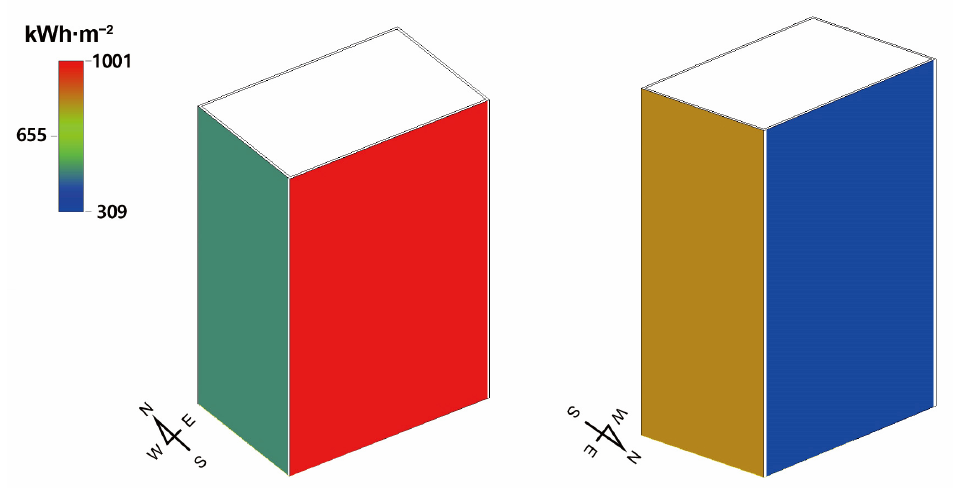
Figure 3. Cumulative solar radiation on the facades of the Signal Box auf dem Wolf for one year in 2022.